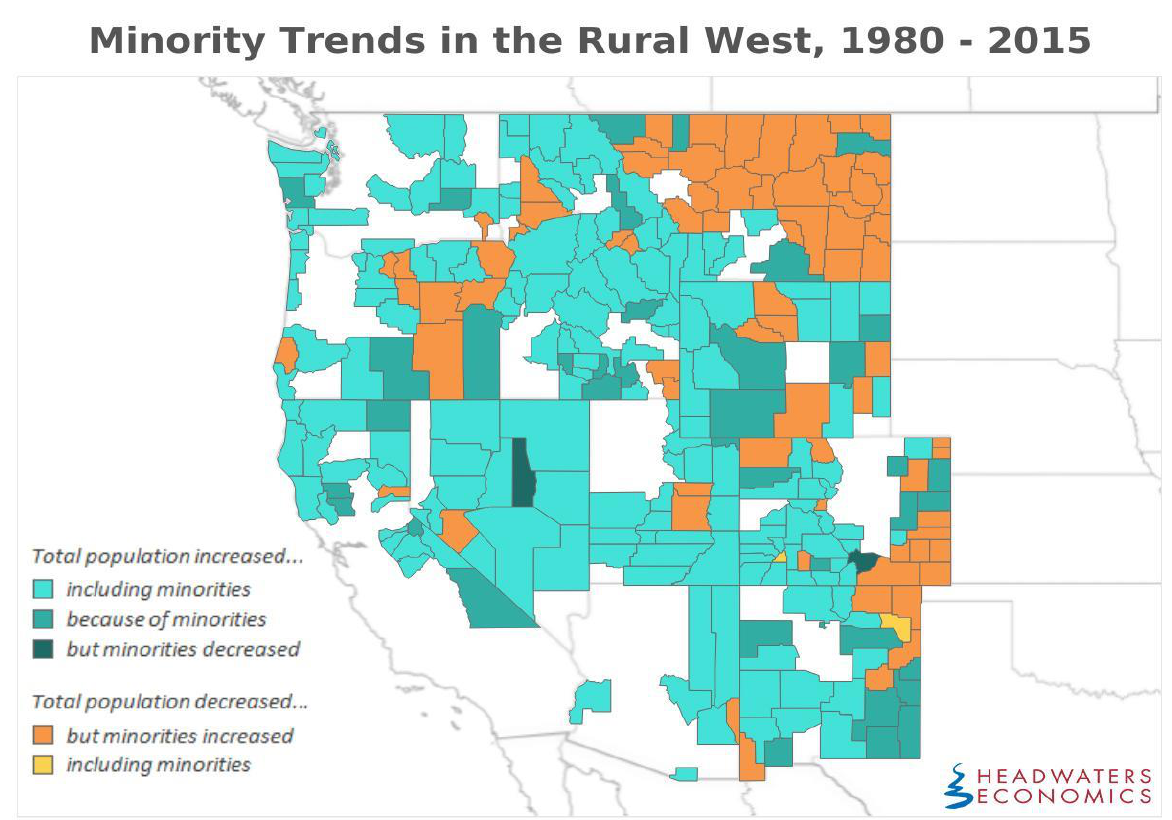
Figure 1. Minority Trends in the Rural West,